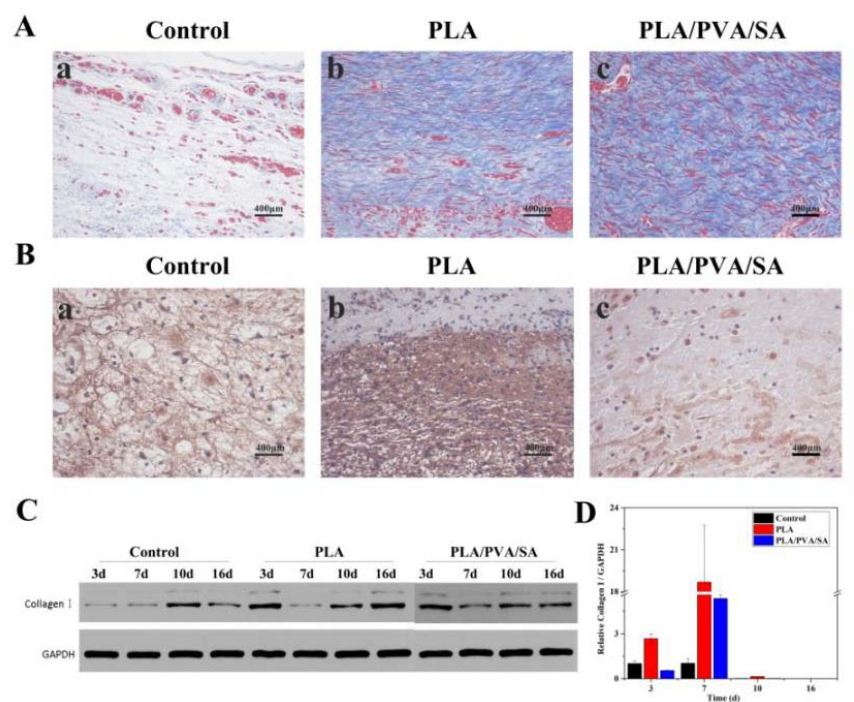
Figure 10. Effects of PLA dressings on wound collagen deposition. ( A ) Masson’s staining on day 16. ( B ) Immunohistochemistry analysis of Collagen I (day 3) ( a ) control; ( b ) PLA group; ( c ) PLA/PVA/SA group. ( C ) Western blot of Collagen I, ( D ) quantitative analysis of the Collagen I deposition.